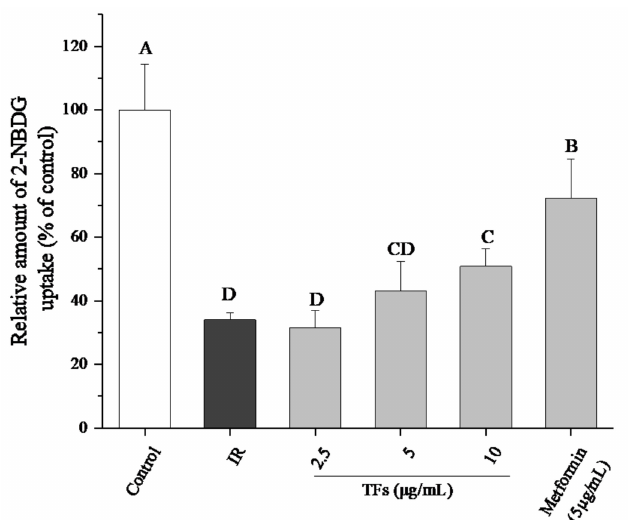
Figure 7. Effects of mdivi-1 on 2-NBDG uptake of insulin-resistant HepG2 cells with theaflavins (TFs) treatment. All six groups were treated with mdivi-1 (10 µ M). Metformin was used as a positive control. Data are represented by means ± SD from five replicates. Significant differences between different treatments are showed by different letters ( p < 0.05).